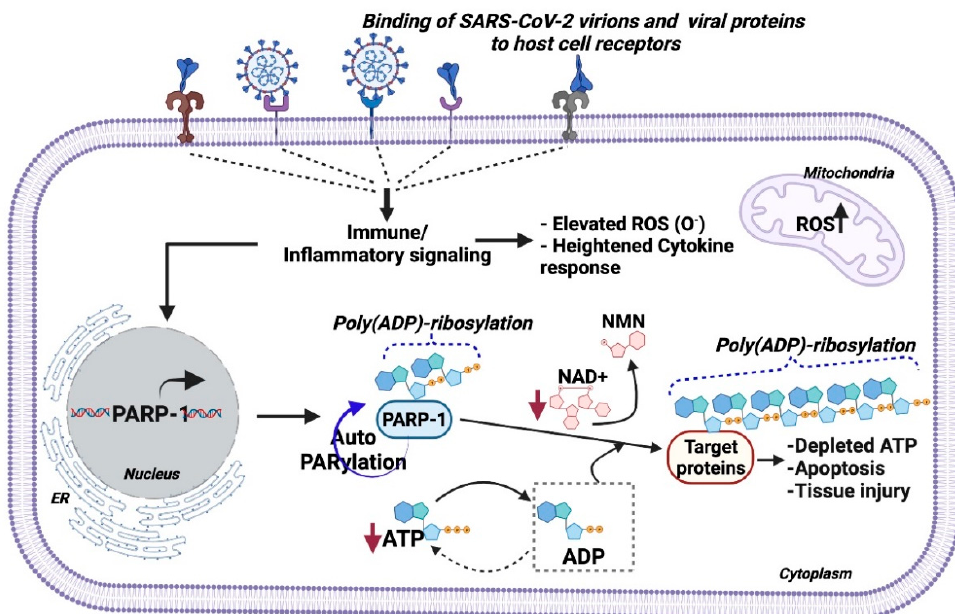
Figure 2. Model for PARP-1 activation in SARS-CoV-2 pathogenesis. Systemic inflammation in SARS-CoV-2 pathogenesis induces immune signaling in cells causing elevated mitochondrial ROS and cytokine response, which triggers PARP-1 transcription and activity. Thereafter, PARP-1 activation PARylates self (autoPARylation) or downstream protein targets by adding Poly (ADP)-ribose residues in a NAD+ dependent manner. Sustained PARylation events under diseased and inflammatory conditions cause declines in intracellular ATP and NAD+ pools, which leads to metabolic dysfunction and cell death, followed by tissue injury, as reported in COVID-19 pathology.